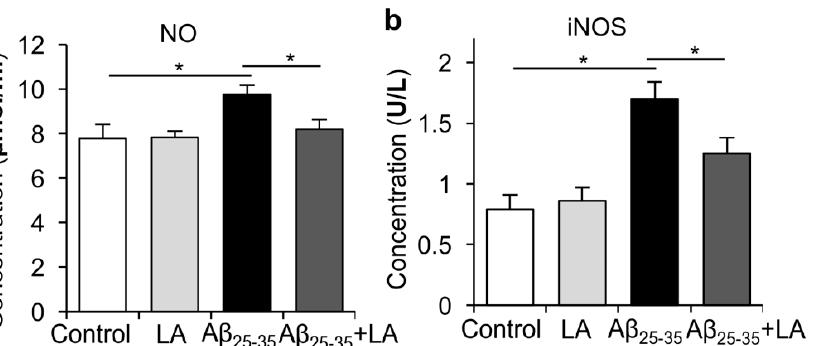
Figure 5. α -lipoic acid (LA) inhibited the increased level of NO and iNOS induced by A β 25–35 . ( a ) Statistical analysis of the release of NO after LA and/or A β 25–35 treatment. ( b ) ELISA was performed to detect the activity of iNOS in BV2 cells. The data are presented as the mean ± SD of three independently performed experiments. * p < 0.05.